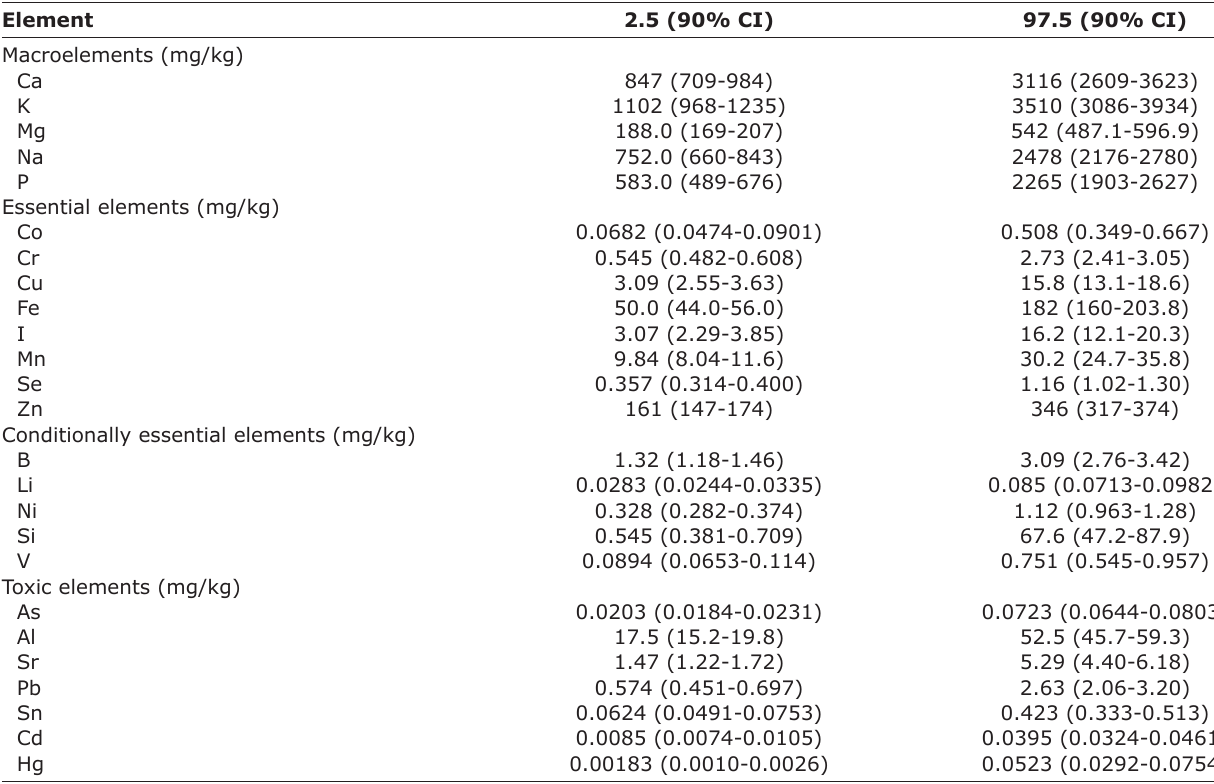
Table-3: Reference ranges of concentrations of essential and toxic elements in laying hens at the age of 10-20 days.